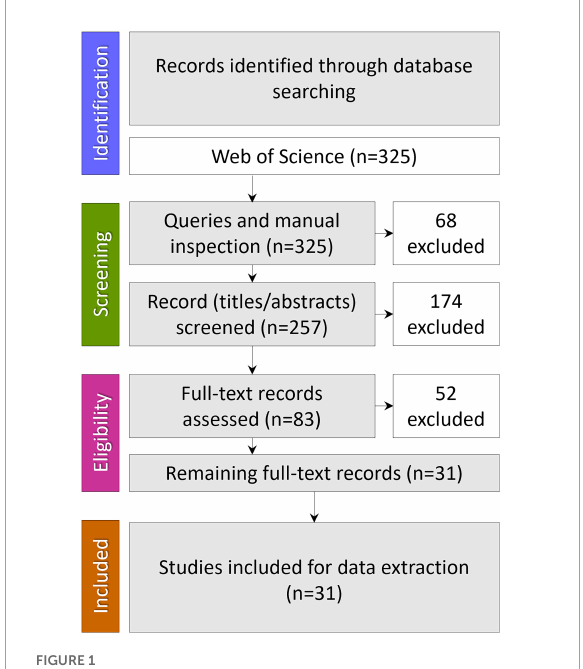
FIGURE1 Data identification, screening, eligibility, and